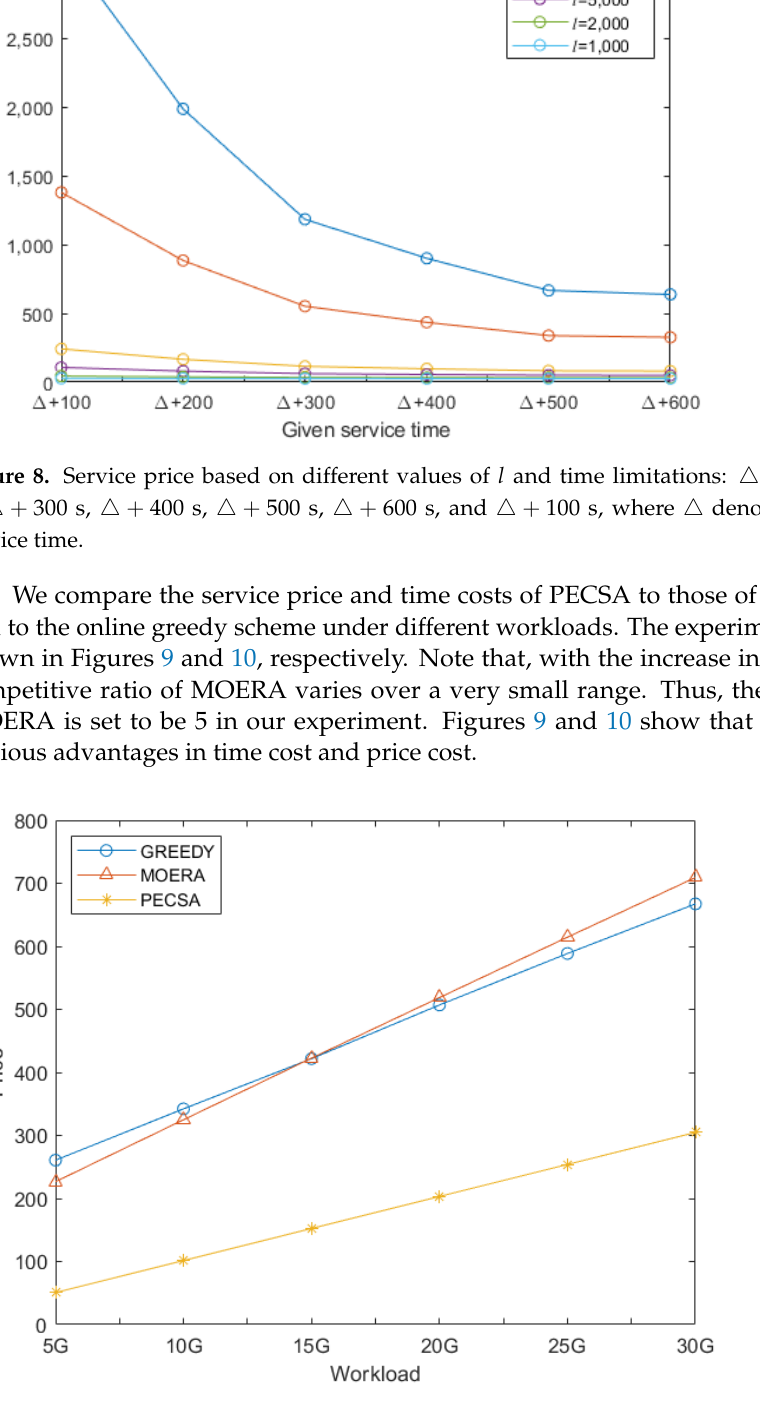
Figure 9. Service price